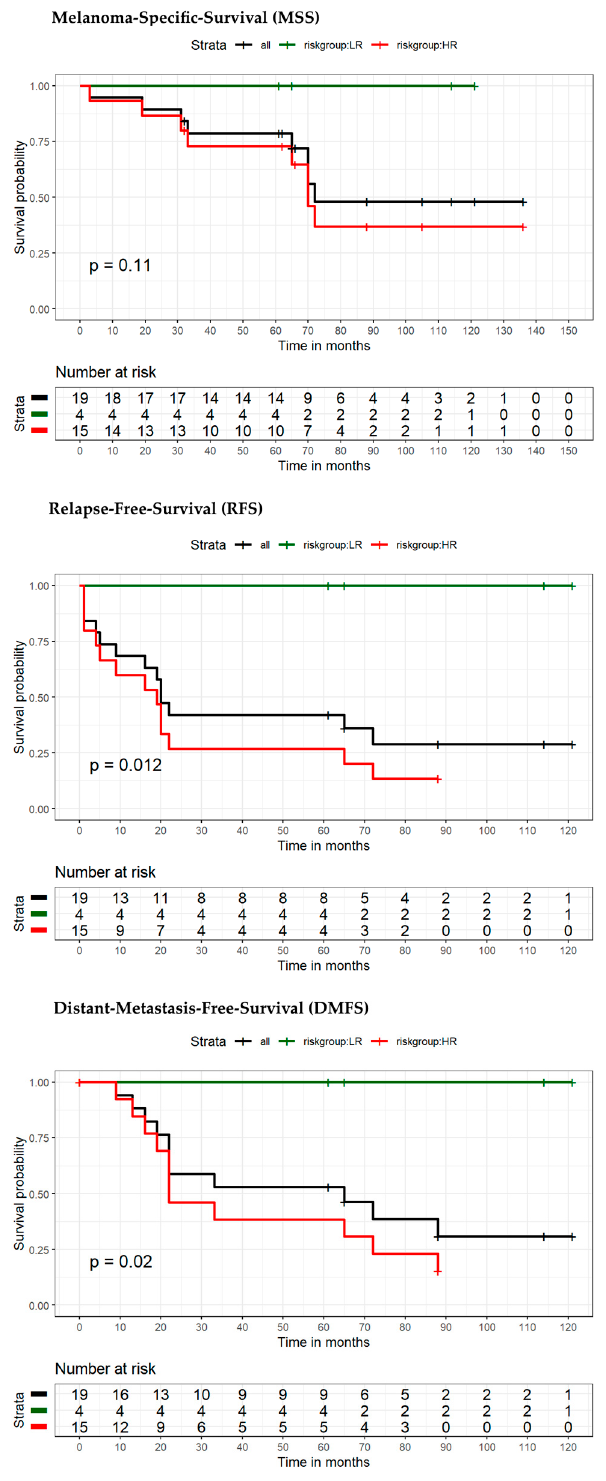
Figure 6. Kaplan–Meier survival estimates of patients with negative nodal status stratified into high- Figure 7. Kaplan–Meier survival estimates of patients with positive nodal status stratified into risk and low-risk by the seven-marker signature. Endpoints were MSS, RFS, and DMFS at 5- and 10- high-risk and low-risk by seven-marker signature. Endpoints were MSS, RFS, DMFS at 5- and 10-year year follow-up. High-risk (in red), low-risk (in green), and all patients (black). Corresponding tables follow-up. High-risk (in red), low-risk (in green) according to the seven-marker signature, and all with the number of patients at risk are given below. patients (black). Corresponding tables with the number of patients at risk are given